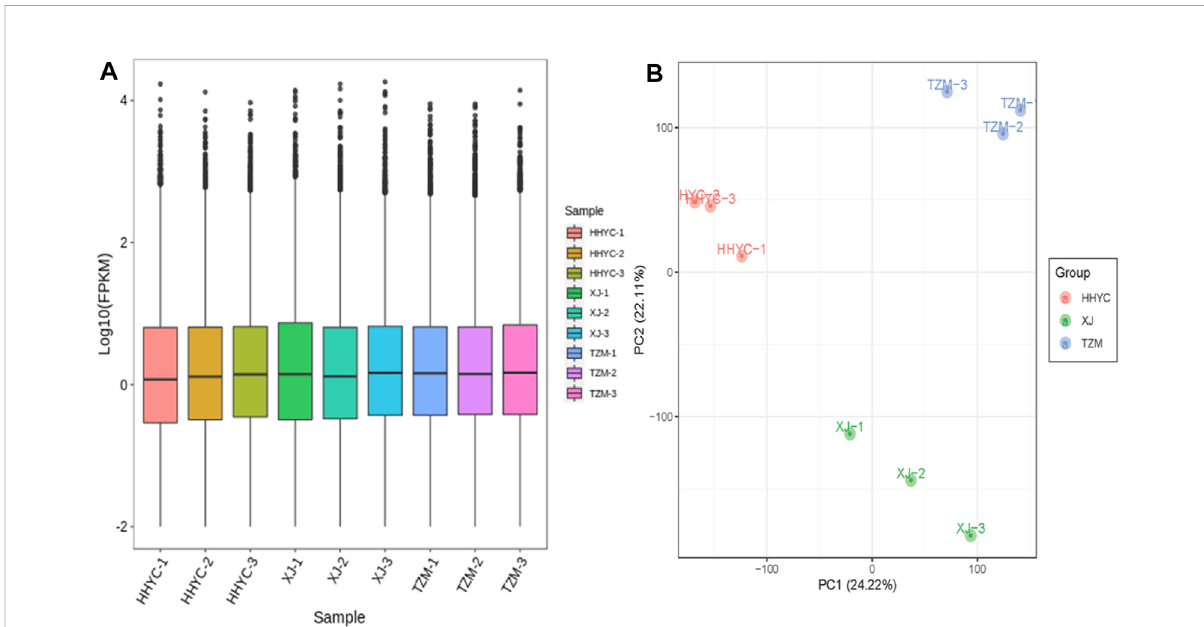
FIGURE 2 Quanti fi cation of fragments per kilobase of exon per million fragments mapped (FPKM) among the nine samples (3 contrasting fl owers × 3biologicalreplicates). (A) .FPKMdistributionamongtheninesamples. (B) .Principalcomponentsanalysisofthreecontrasting fl owersof C.reticulata (HHYC1-3), C. reticulata ‘ Xuejiao ’ (XJ1-3) and C. reticulata ‘ Tongzimian ’ (TZM1-3).